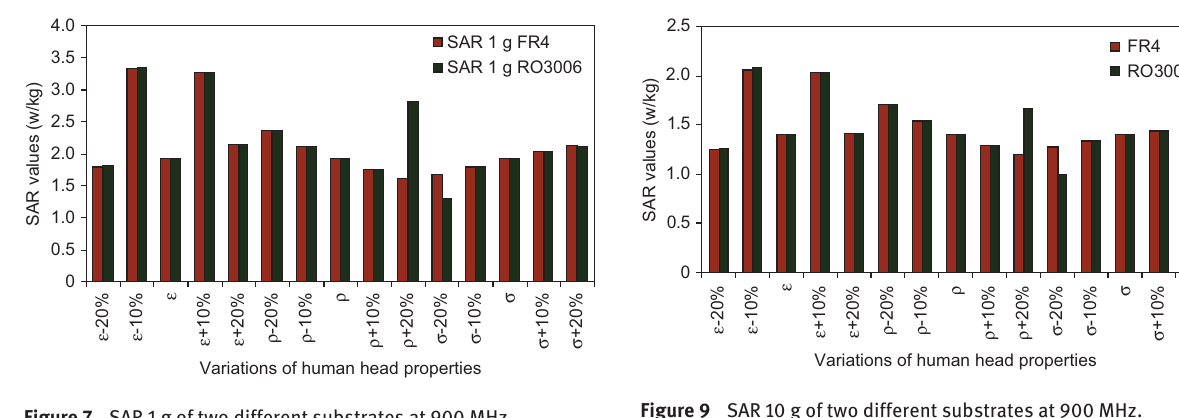
Figure 7 SAR 1 g of two different substrates at 900 MHz.